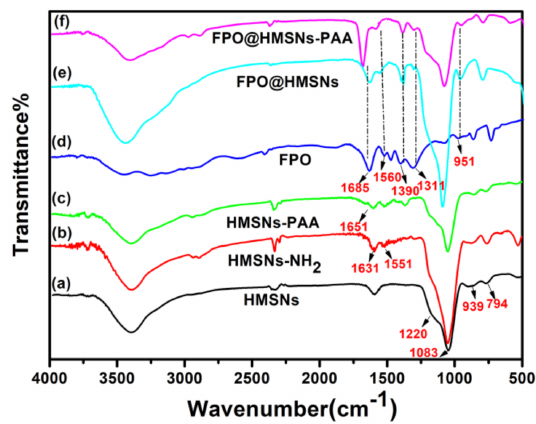
Figure 3. Fourier transform infrared (FTIR) spectra of ( a ) HMSNs; ( b ) HMSNs-NH 2 ; ( c ) HMSNs-PAA; ( d ) FPO; ( e ) FPO@HMSNs and ( f ) FPO@HMSNs-PAA.